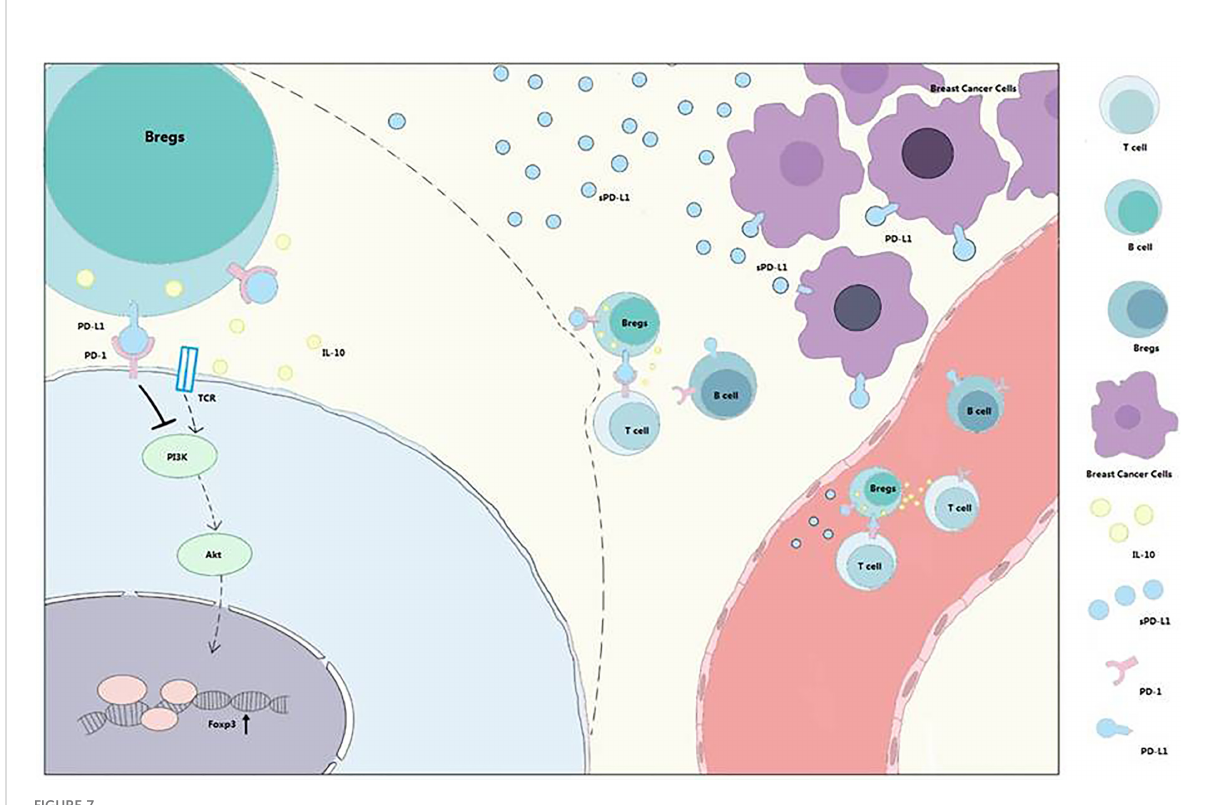
FIGURE 7 PD-1/PD-L1 signaling in Bregs differentiation and function. Bregs differentiation occurs in the TME or immune system of patients with breast cancer. sPD-L1 from breast cancer could upregulate the expression of CD24 and CD38 on CD19 + B cells and promote IL-10 secretion from CD24 + CD38 + CD19 + Bregs. With the interaction of B cells and T cells, PD-1/PD-L1 signaling contributes to T regs promotion and effector T-cell (Teff) exhaustion. Meanwhile, sPD-L1 is also released into blood to further interact with CD19 + B cells and promotes differentiation and promotion of Bregs and T regs